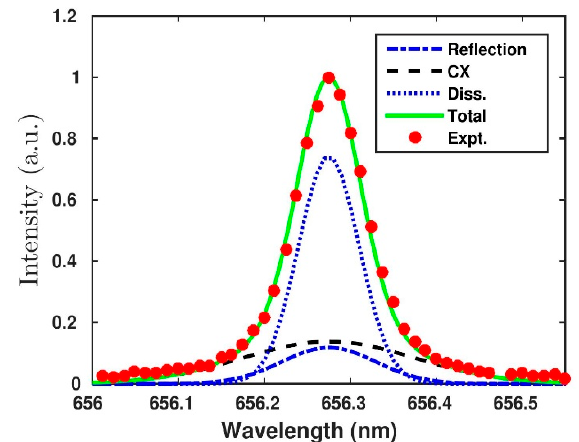
Figure 3. H α spectrum from the DEGAS2 code along with the experimental measurements. The spectrum represented by legend ‘Diss.’ (dotted line) shows contribution in H α emission from the dissociation processes including all the reaction pathways having product atoms at ground state and directly to n = 3 state except the charge-exchange process. The spectrum represented by legend ‘CX’ (dashed line) shows the contribution in H α emission from product atoms in ground state through the charge-exchange process. The spectrum represented by legend ‘Reflection’ (dash-dot line) shows the contribution from the plasma-material interaction process. ‘Total’ (Solid line) represents the addition of all the different contributions.